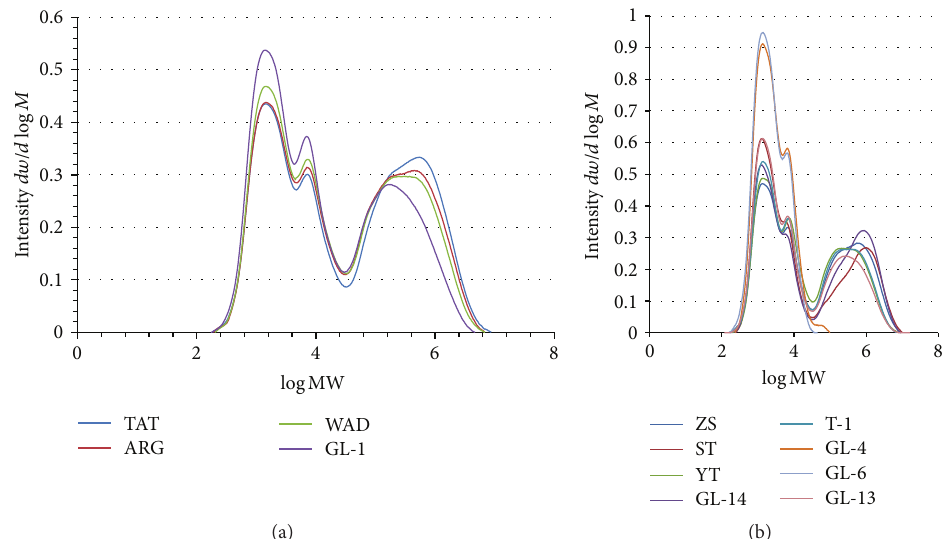
Figure 8: GPC profile for debranched starches from grain (a) and sweet (b) sorghum varieties.